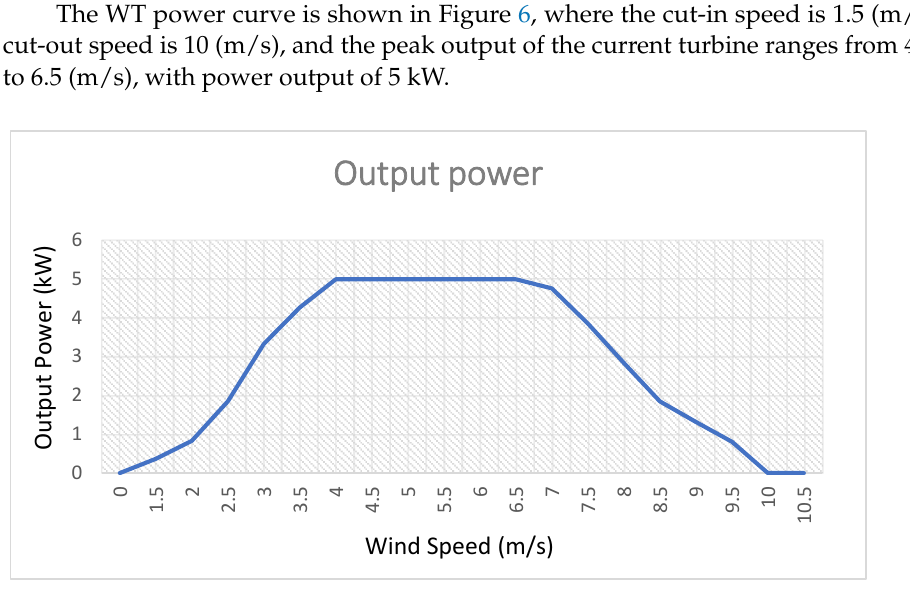
Figure 6. The RC ‐ 5K ‐ A power curve. Figure 6. The RC-5K-A power curve.